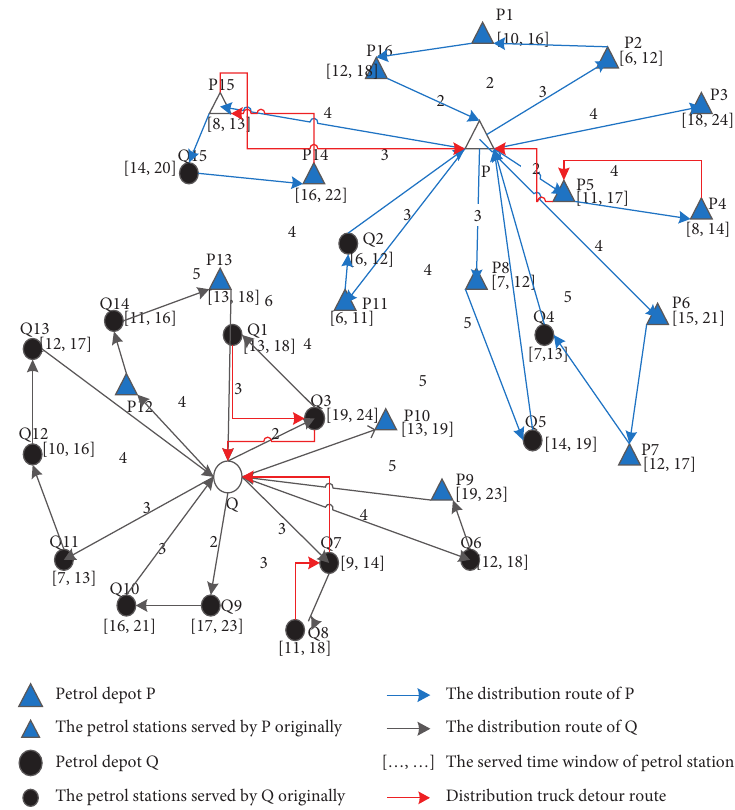
Figure 2: Cooperative petrol distribution